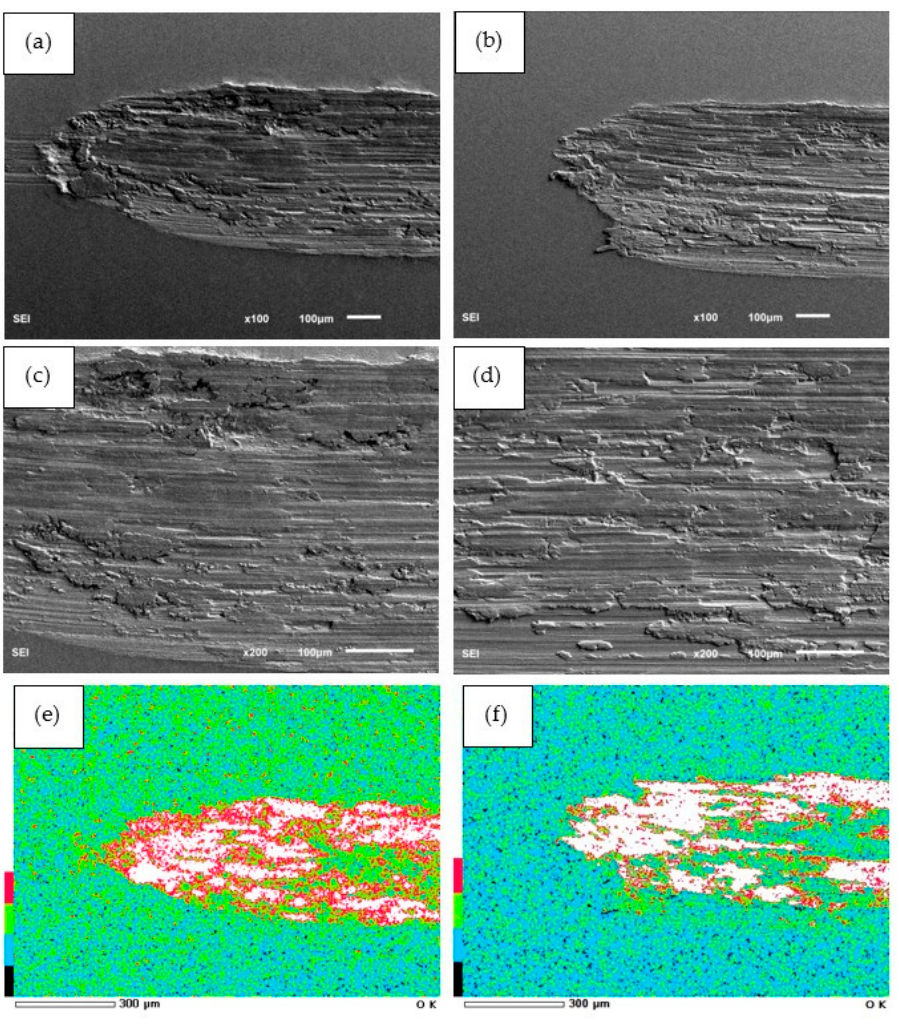
Figure 6. SEM images of abrasion scars: ( a,c ) as-cast; ( b,d ) LSRed. EDS map showing the oxygen distribution of the abrasion scars: ( e ) as-cast; ( f ) LSRed.